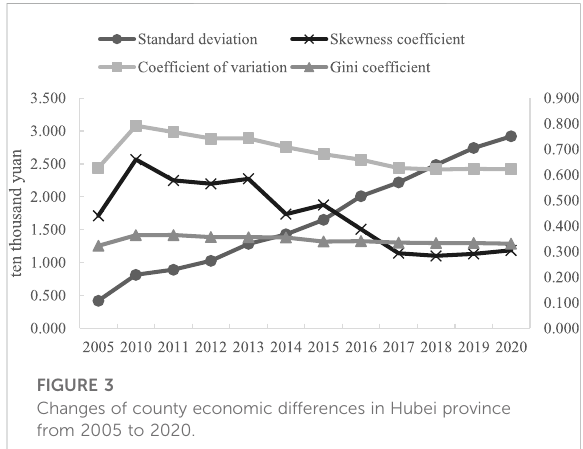
FIGURE 3 Changes of county economic differences in Hubei province from 2005 to